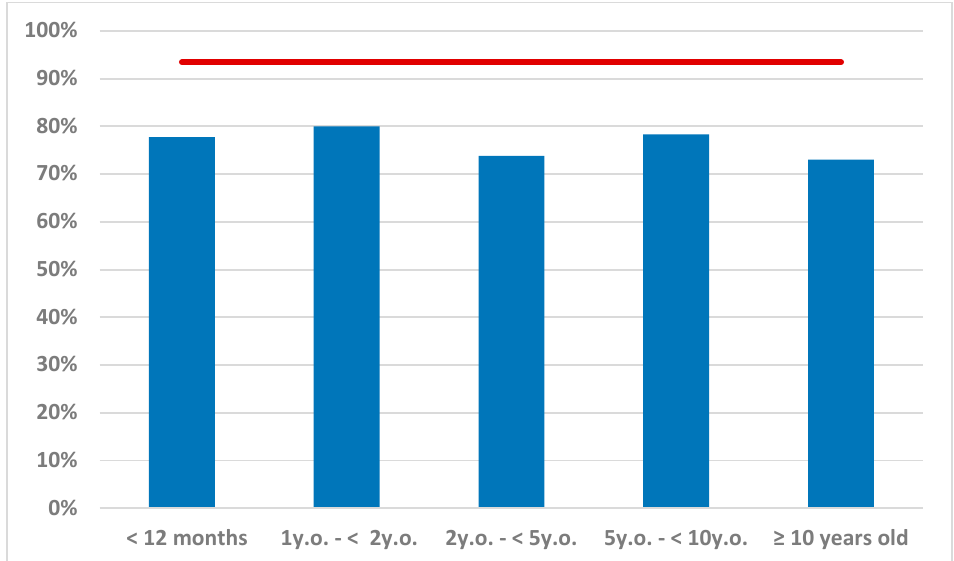
Figure 2. Estimated herd immunity threshold (red line) based on R 0 = 15.3, and numbers of second- ary cases in each age sub-cohort if a single infectious individual had contact with the remaining susceptible individuals (Re).